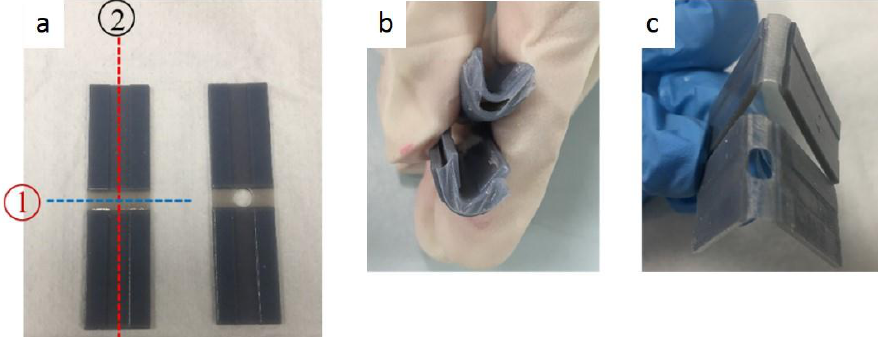
Figure 24. Crossfolding for the 0.1 mm sample. ( a ) Printed specimens with and without a hole; ( b ) Method 2—Folding line 1, followed by folding line 2; ( c ) After recovery.